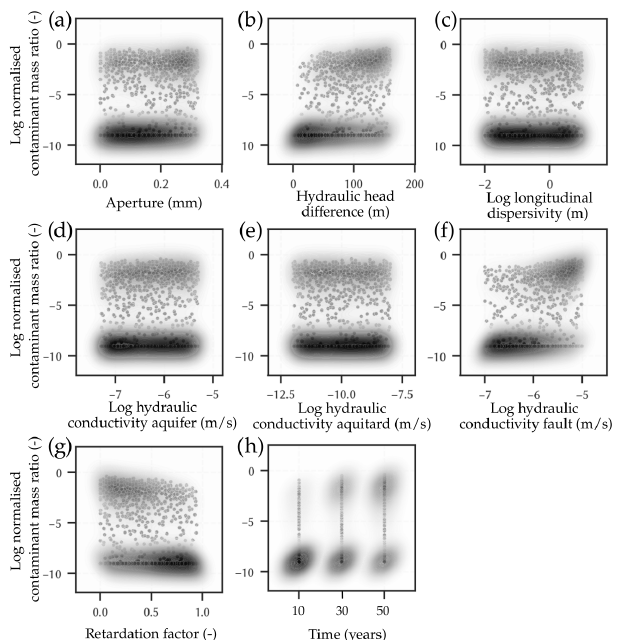
Figure 8. Distribution of all input parameters of the thermo- hydrogeological model of the Máza-Váralja study area against the output contaminant mass ratio in the aquifer with kernel density estimations of the points (shades): (a) fracture aperture, (b) lat- eral hydraulic head difference, (c) longitudinal dispersion length, (d) hydraulic aquifer conductivity, (e) hydraulic aquitard conduc- tivity, (f) regional fault hydraulic conductivity, (g) retardation coef- ficient, and (h) simulation time.